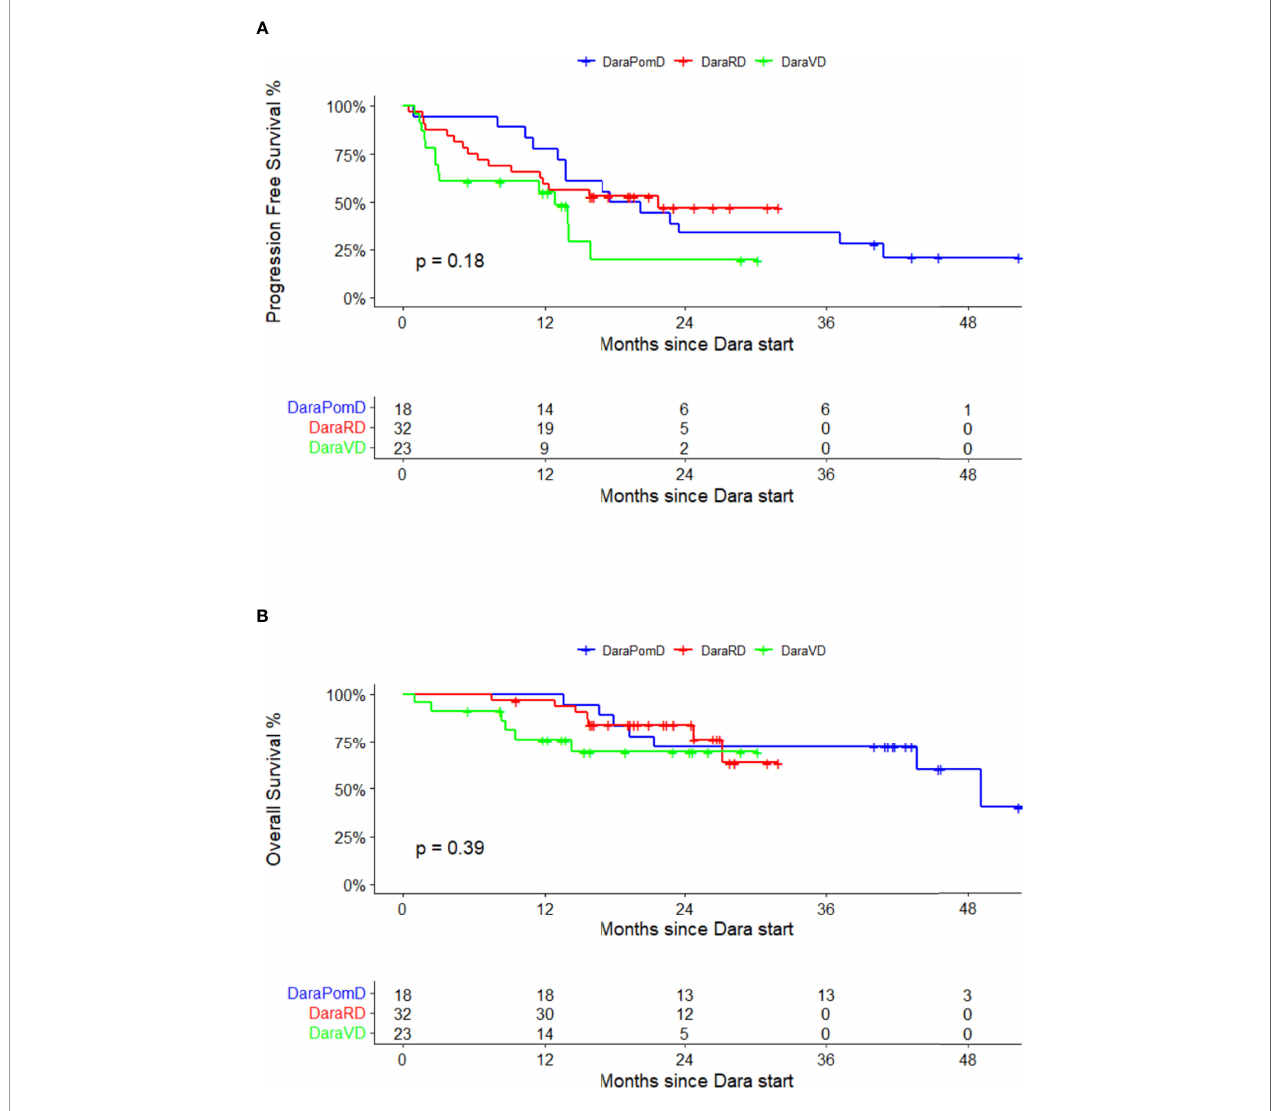
FIGURE 1 | Daratumumab-containing regimens post-lenalidomide maintenance. (A) Progression-free survival. (B) Overall